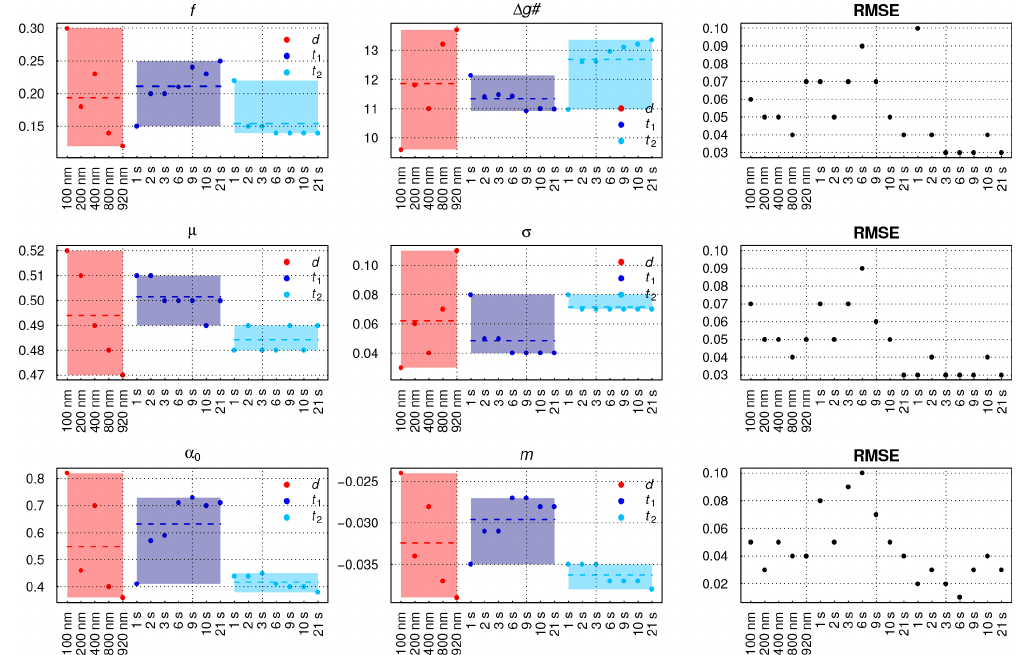
Figure C1. Variability of the fit parameters for subsets of the kaolinite dataset. The variability with the aerosol particle size ( d ) is shown for a residence time t of 10s (red). The variability with time ( t 1 and t 2 ) is shown for a aerosol particle diameter of 400nm ( t 1 , blue) and 800nm ( t 2 , light blue). The first row shows the fit results for CNT2, the second row for CNT5, and the third row for CNT7. The RMSE value shows the deviation of the fit to the single dataset it was fitted to.